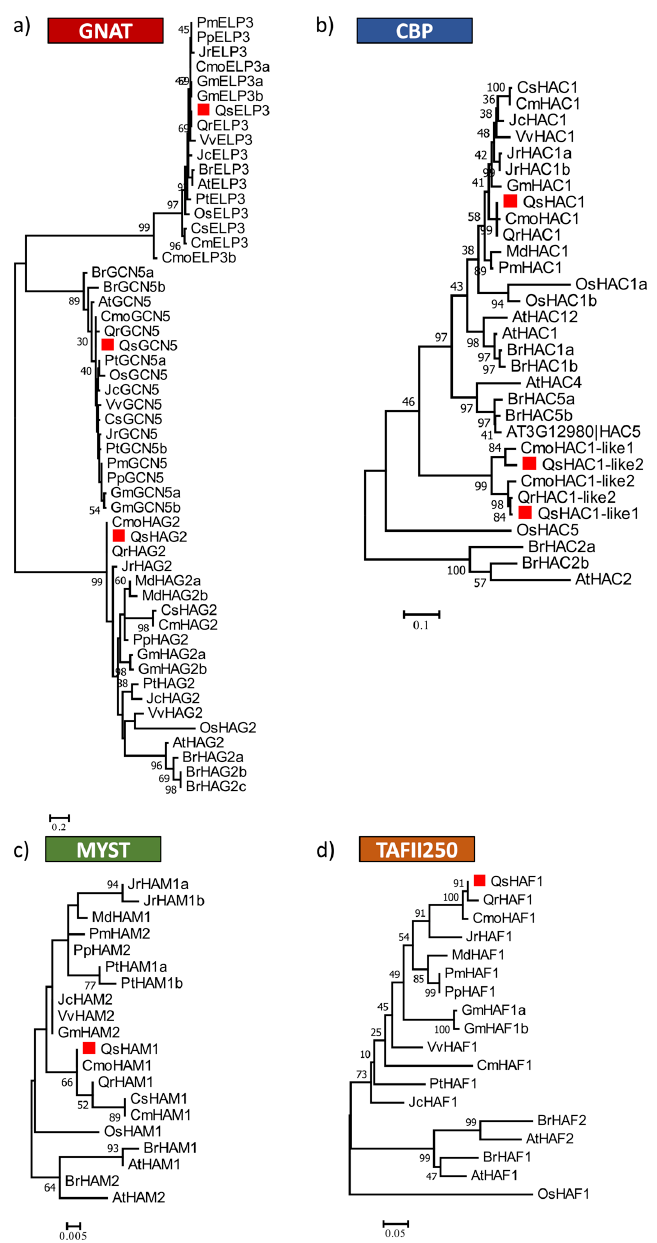
Figure 4. Phylogeny of HAT proteins of GNAT ( A ), CBP ( B ), MYST ( C ), and TAFII250 ( D ) family. The Acetyltransf_1 domain (GNAT) or the KAT11 domain (CBP), the MOZ_SAS domain (MYST) and the UBQ and BROMO domains (TAFII250) of Quercus suber L. (Qs), Arabidopsis thaliana (L.) Heynh. (At), Brassica rapa L. (Br), Glycine max (L.) Merr. (Gm), Jatropha curcas L. (Jc), Populus trichocarpa Torr. & A.Gray ex Hook. (Pt), Prunus persica (L.) Batsch (Pp), Prunus mume (Siebold) Siebold & Zucc. (Pm), Vitis vinifera L. (Vv), Cucumis melo L. (Cm), Cucumis sativus L. (Cs), Juglans regia L. (Jr), Castanea mollissima Blume (Cmo), Quercus robur L. (Qr) and Oryza sativa L. (Os) were aligned using ClustalW and used to infer the evolutionary history using the Maximum-likelihood method. The evolutionary distances (left side scale bar) were computed using the Jones-Taylor-Thornton (JTT) correction model. The numbers at the nodes represent bootstrap values from 1000 replicates. The Q. suber proteins are indicated with a red